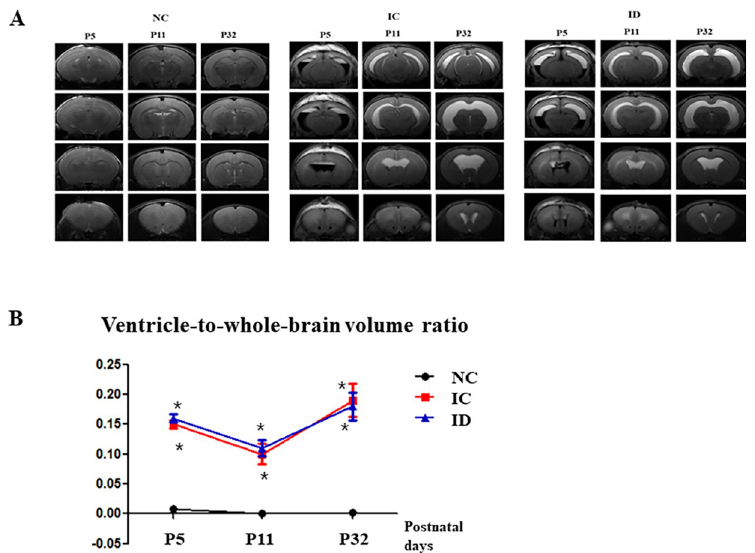
Fig 3. Postnatal dexamethasone did not attenuate ventricular dilatation after induced IVH. (A) Brain MRI serials of the three groups. (B) Ventricle-to-whole-brain volume ratio . The numbers are expressed as the mean ± SEM. MRI refers to magnetic resonance imaging. IVH refers to intraventricular hemorrhage. � P < .05 compared to the normal control (NC, n = 9). IC, IVH control (n = 20); ID, IVH + dexamethasone (n = 21).